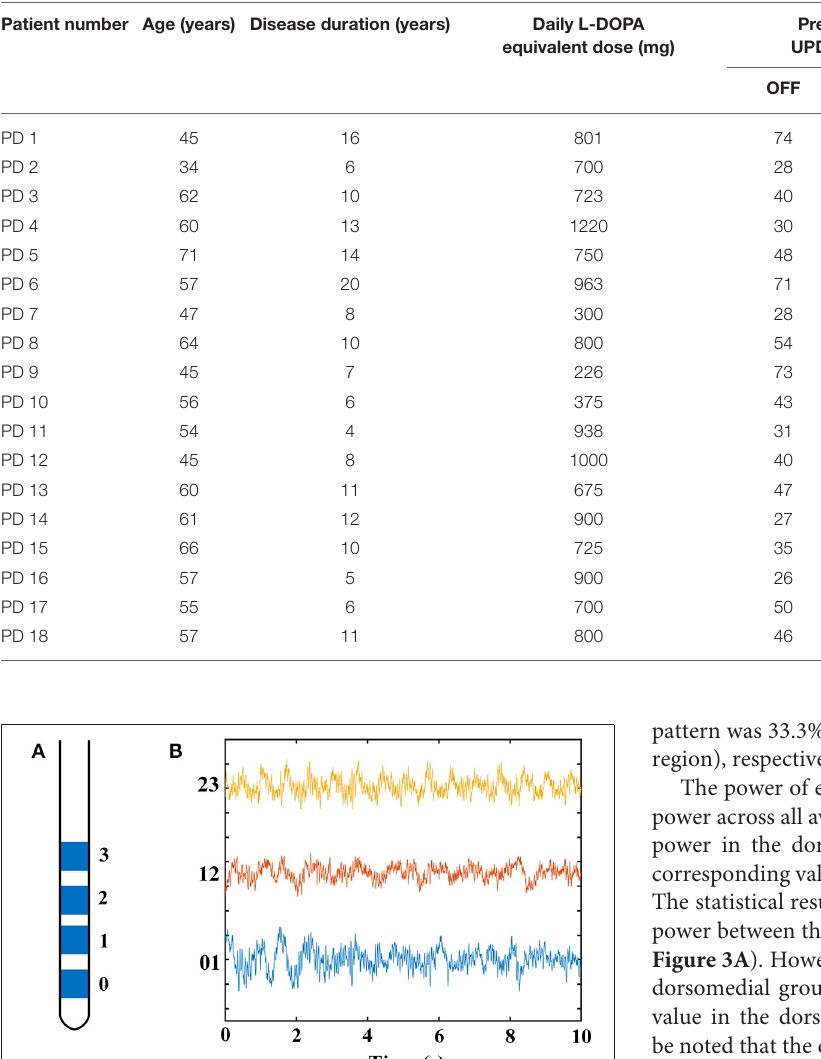
TABLE 1 | Patient demographic and clinical characterization.